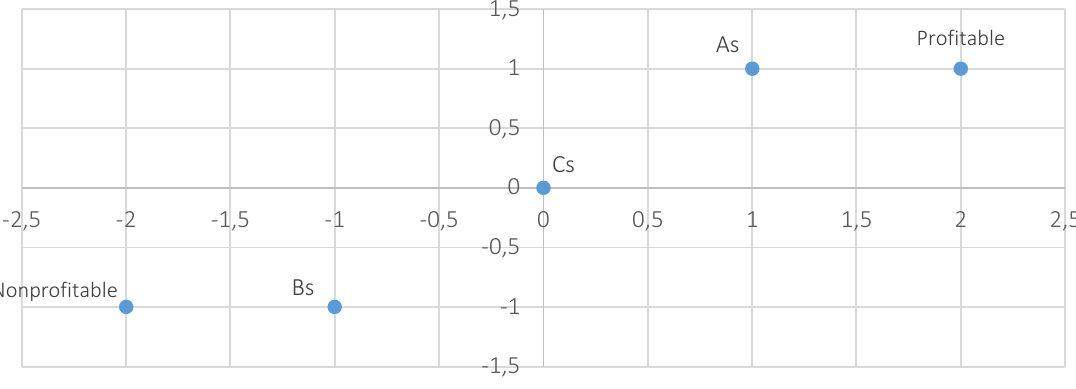
Figure 1. Representation of the social factorial correspondence analysis